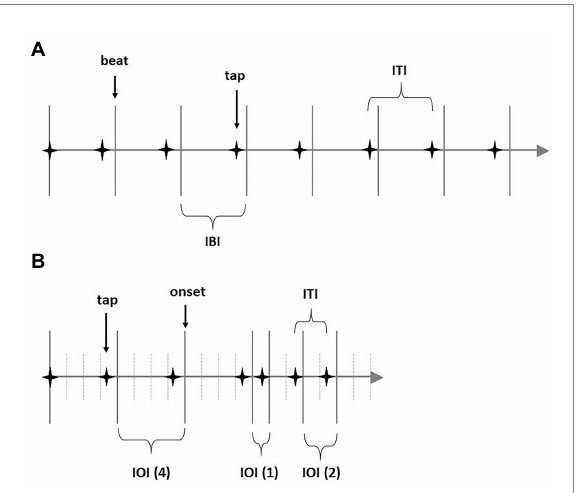
FIGURE 1 (A) Schematic representation of isochronous beat pattern (here with 8 beats). (B) Schematic representation of a rhythmic pattern (here with pattern 4:4:4:1:2:2). IBI, inter-beat-interval; ITI, inter- tap-interval; tap, finger press to synchronize a beat in A ; IOI, inter-onset-interval; tap, finger press to synchronize with onset in B